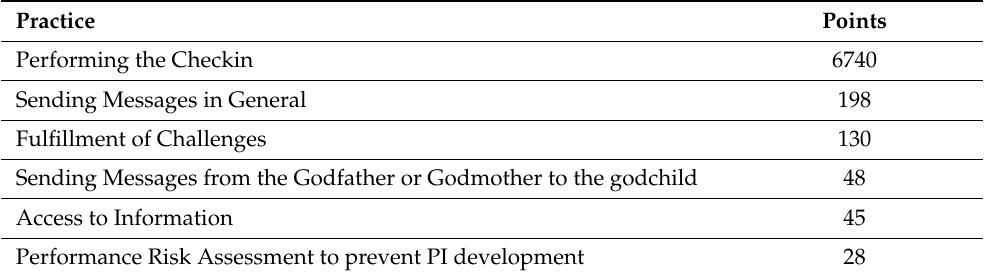
Table 5. Points accumulated per practice.